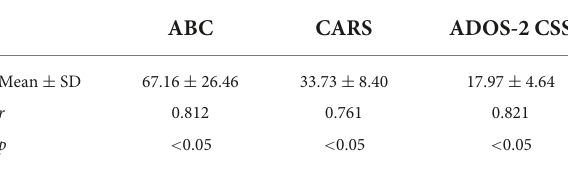
TABLE 2 Correlations between the communication warning behavior scores and established autism scales ( n =